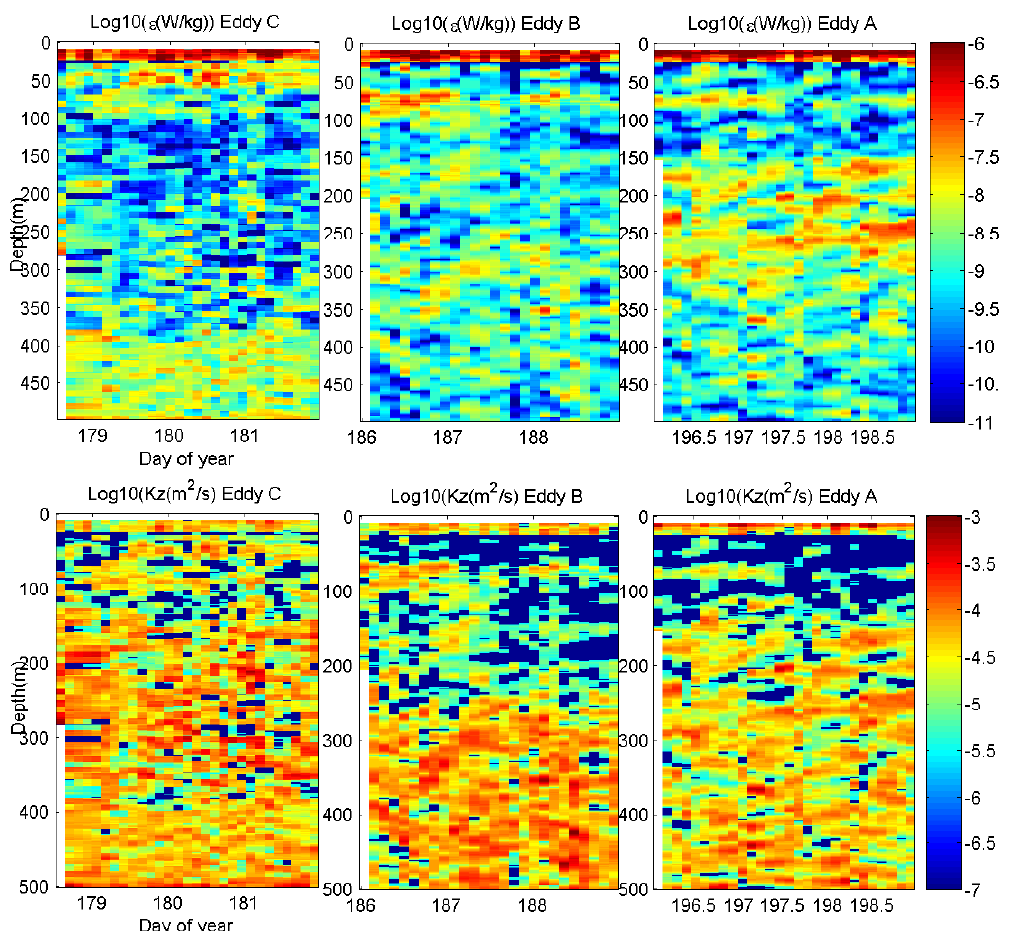
Fig. 11. Parameterized dissipation rate (cid:15) param (a) and diapycnal diffusion coefficient K z,param (b) as a function of time and depth for the Figure 11: Parameterized dissipation rate ϵ param (a) and diapycnal di(cid:27)usion coe(cid:30)cient three K z,param (b) as a function of time and depth for the three stations.